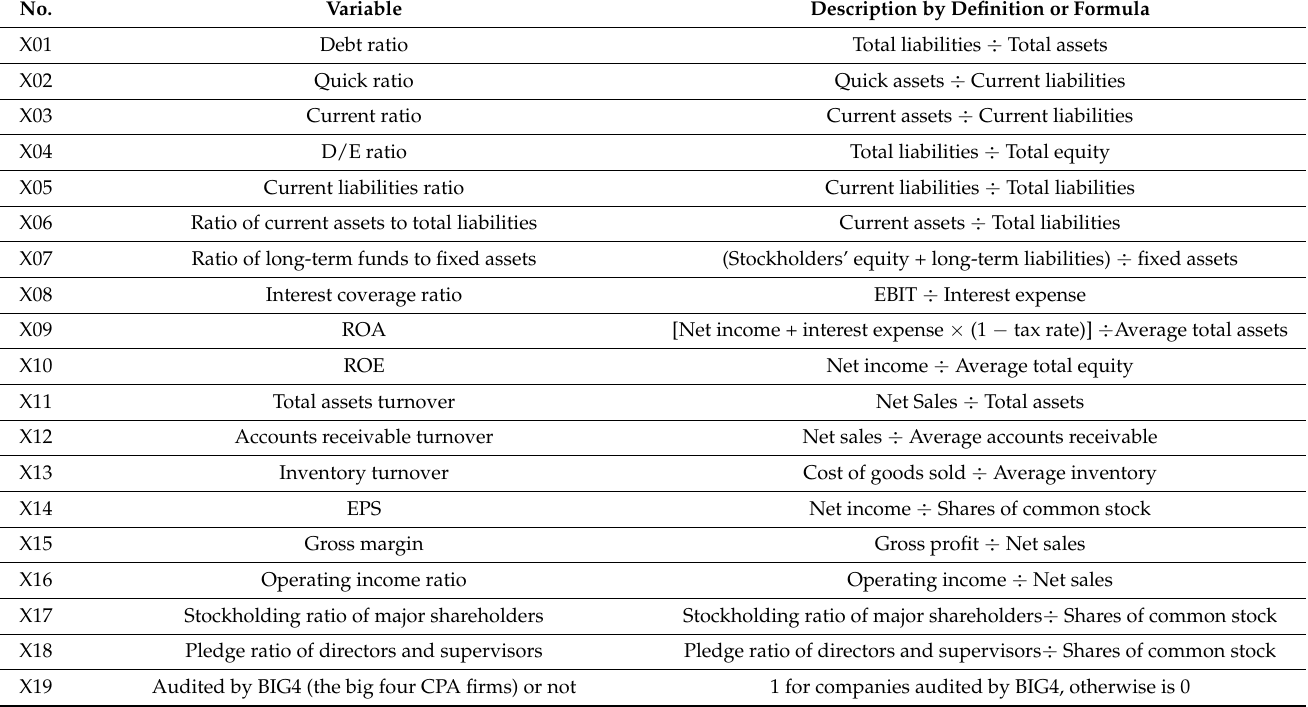
Table 2. Research